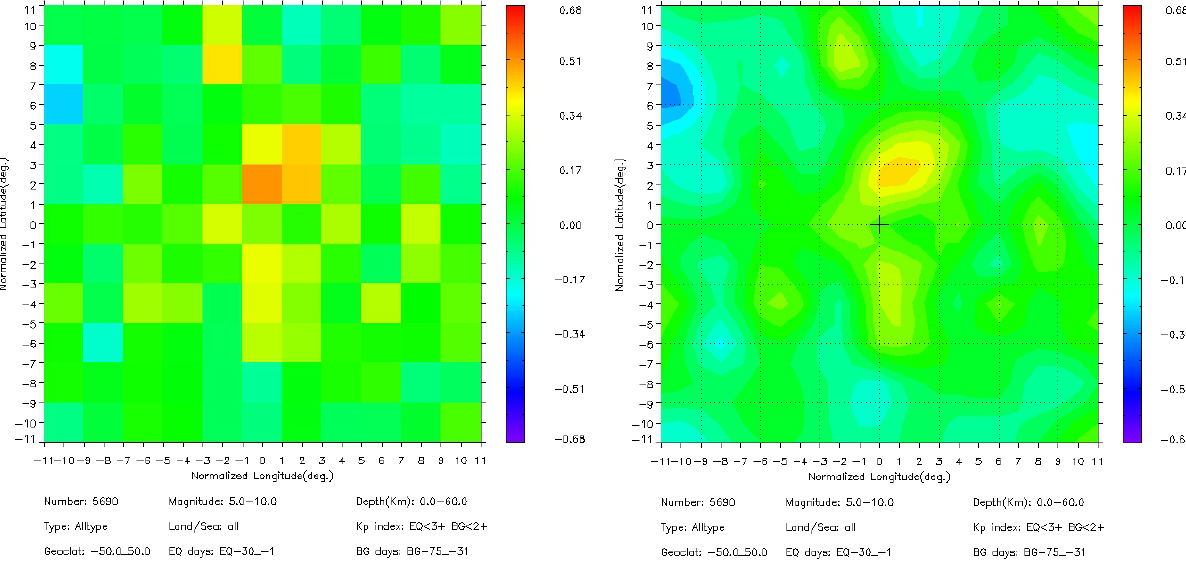
Fig. 7. The plots are similar to those of Fig. 2, but it concerns statistical results when the post seismic effect is